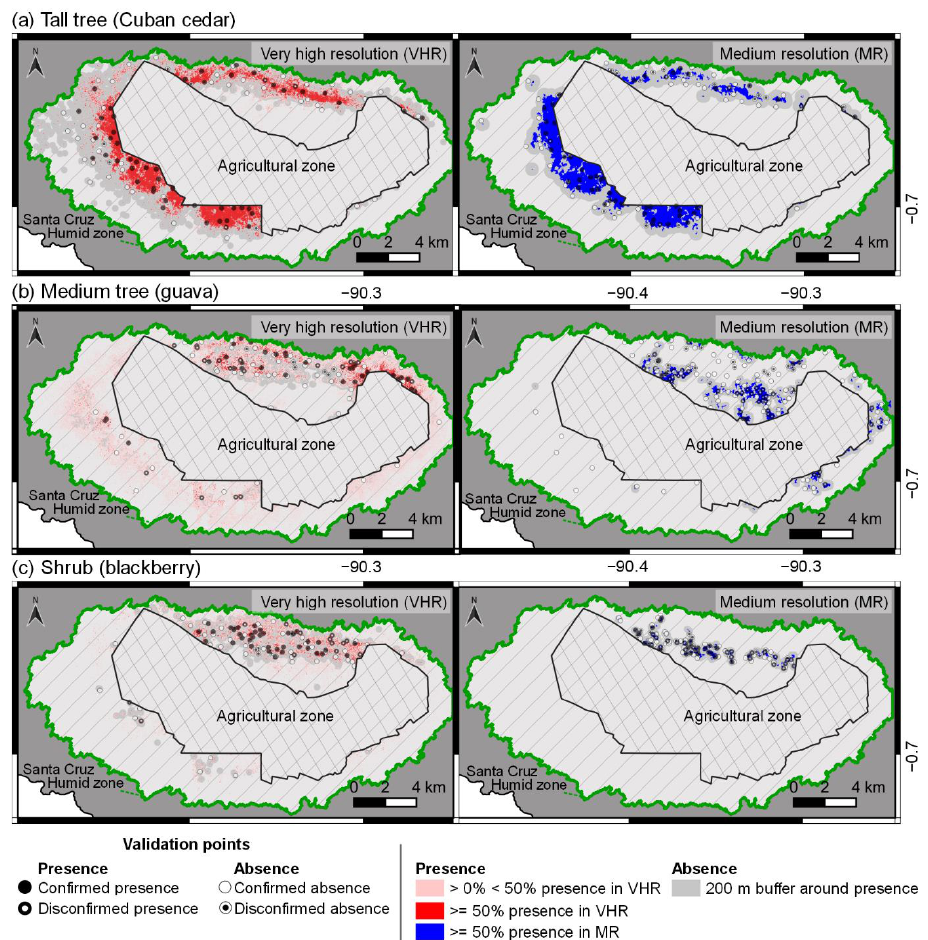
Figure A2. Validation points from maps generated with very-high-resolution (VHR) imagery (red for areas dominated by a species in more than 50% and light red for areas with a presence between 0% and 50%) and medium-resolution (MR) imagery (blue for areas dominated by a species) for: ( a ) tall tree growth form (Cuban cedar); ( b ) medium tree growth form (guava); and ( c ) shrub growth form (blackberry). In both VHR and MR maps, a 200 m buffer around the areas of dominated presence are represented in light gray. Confirmed presences are represented as black circles and confirmed absences are represented as white circles. Disconfirmed presences are represented as black circles with a white center and disconfirmed absences are represented as white circles with a black center. A georeferenced list of these points can be found in the supplementary materials section.